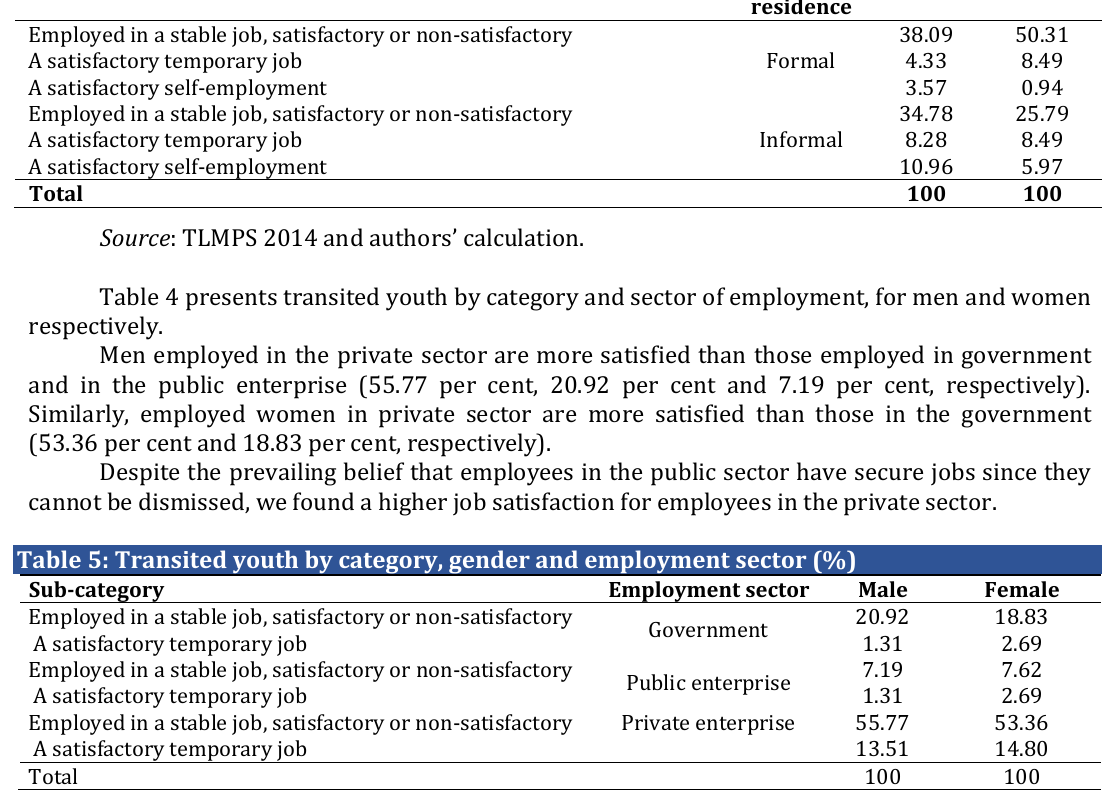
Source : TLMPS 2014 and authors’ calculation Table 4: Transited youth by category, gender and formality (%) Sub-category Gender /